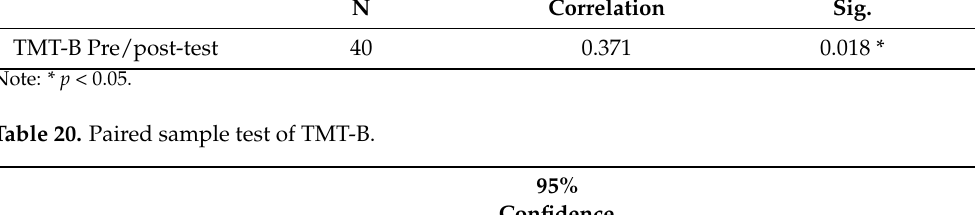
95% Confidence Interval of the